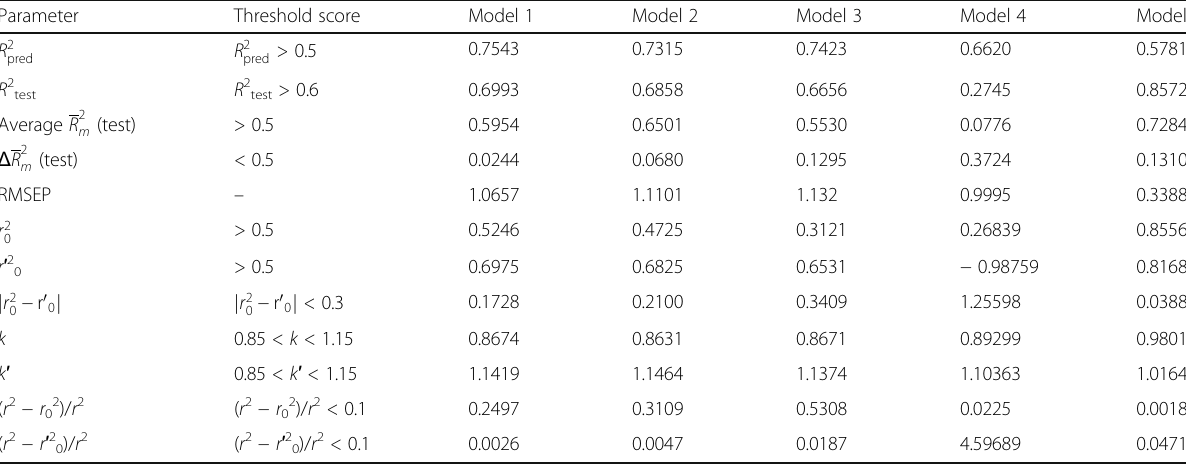
Table 3 External validation of the models